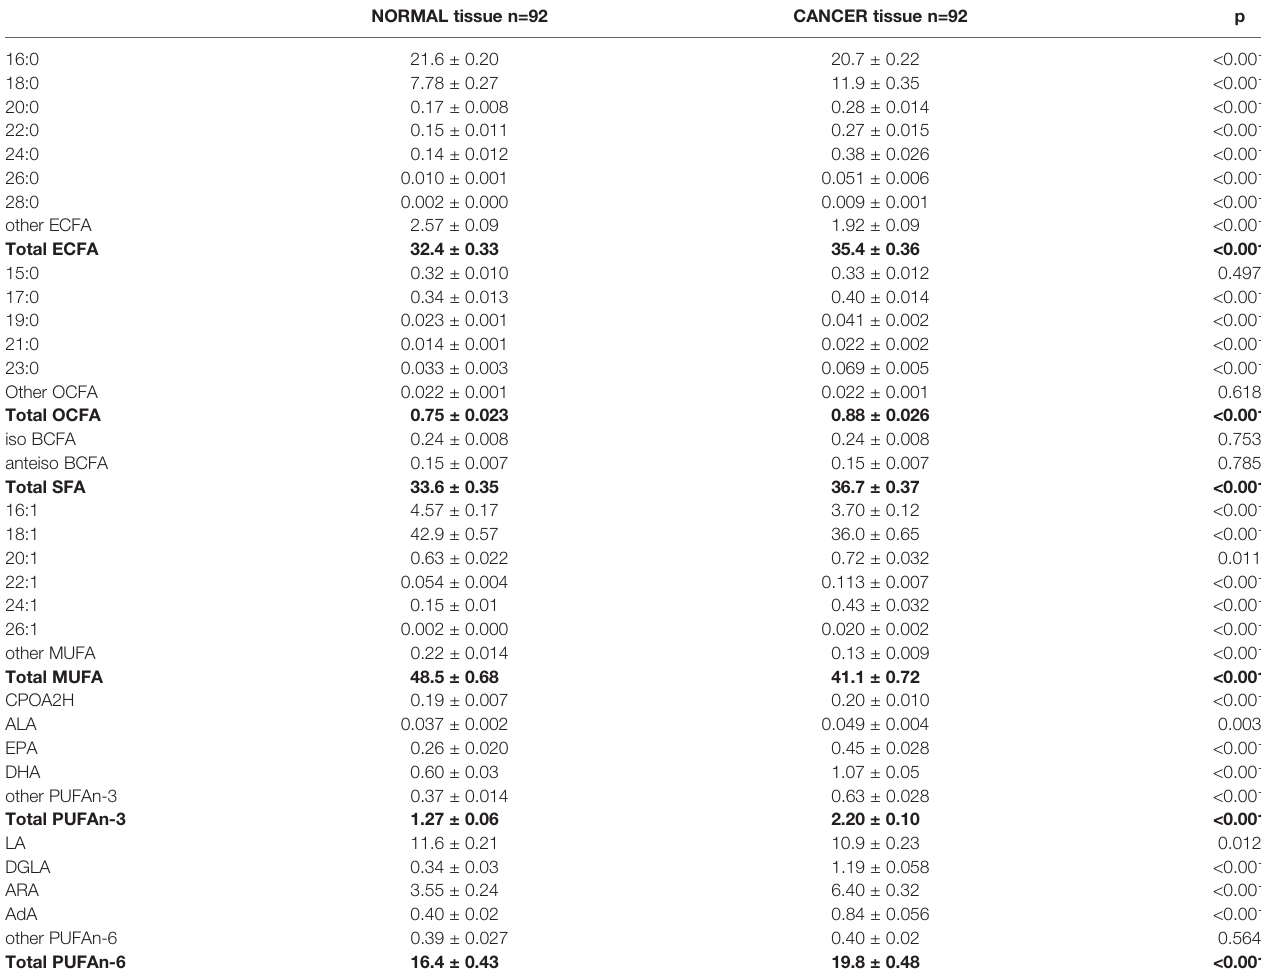
TABLE 4 | Pro fi le of fatty acids (%) in normal mucosa and CRC tissues. NORMAL tissue n=92 CANCER tissue